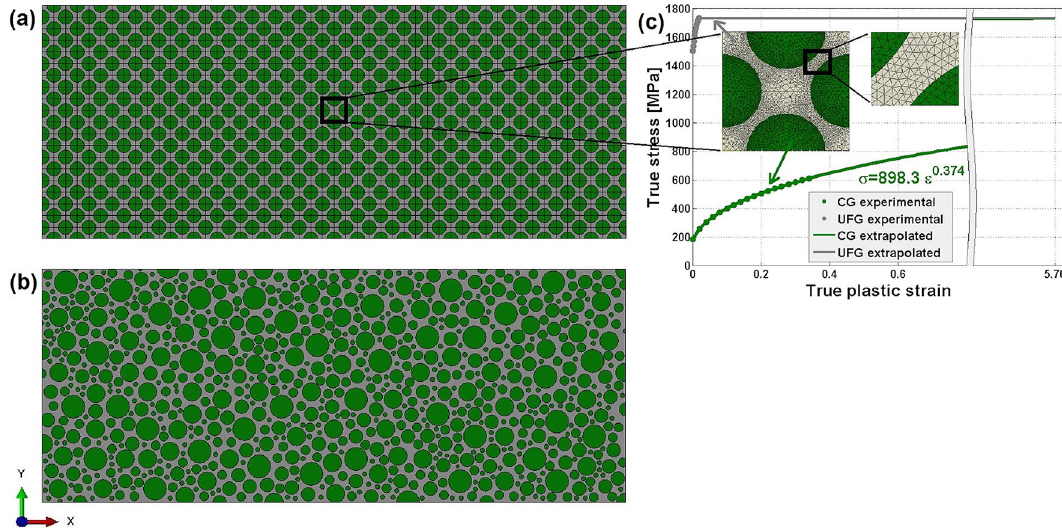
Figure 10. 2D models for ( a ) bHS and ( b ) bR samples where green and grey areas represent CG and UFG structure phases, respectively; ( c ) tensile curves for the effective true stress versus true plastic strain used for describing the rheology of CG and UFG phases in the simulations. Experimental stress–strain data are shown by dots, while Ludwig-Hollomon relationship fit by solid lines. Insets in ( c ) show magnified views of the meshed bHS unit